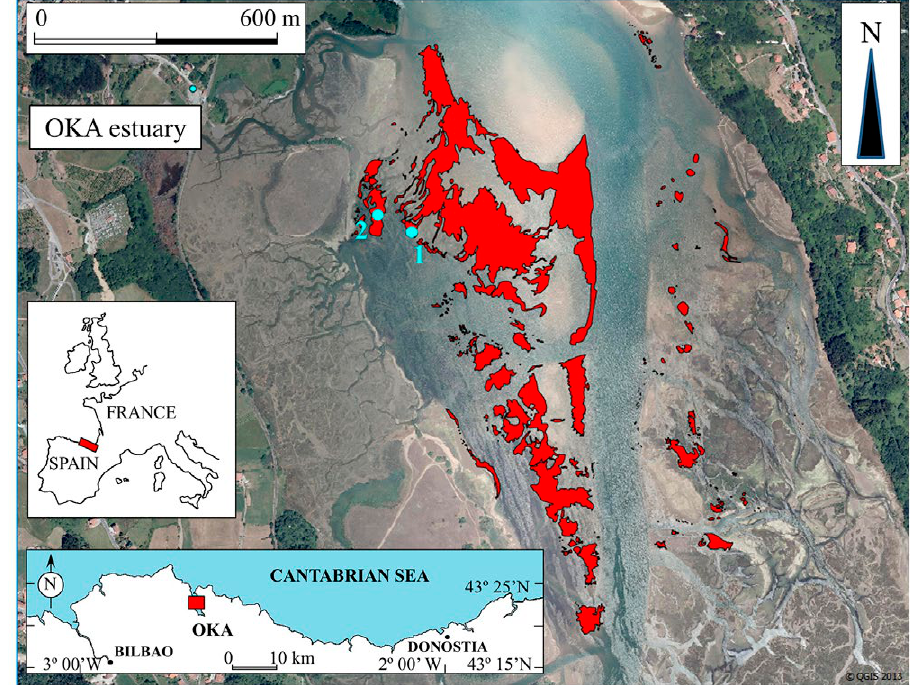
Fig. 1. – Study area. Middle section of the Oka estuary. In red, area occupied by seagrasses in 2012. Location of experiment areas: plot 1; plot